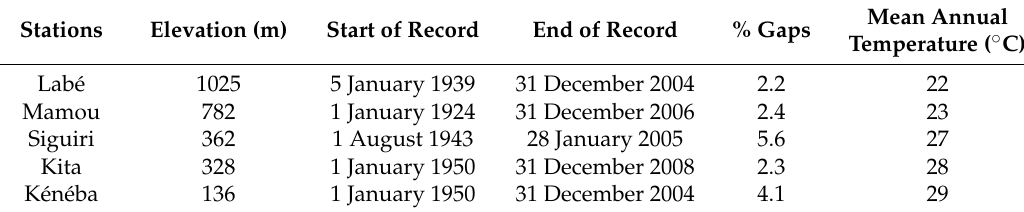
Table 2. Inventory of available temperature